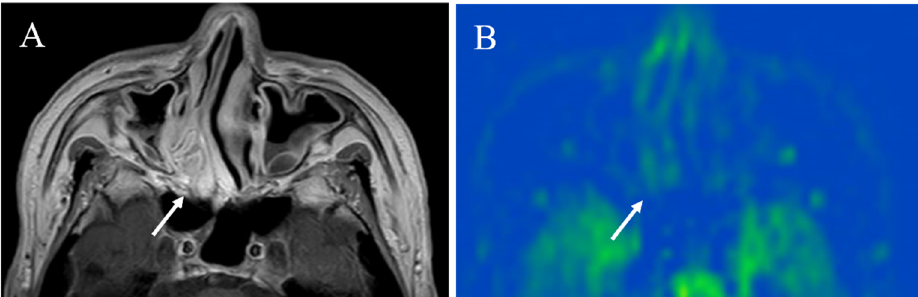
Figure 13. A 73-year-old male with inverted papilloma: ( A ) Contrast-enhanced T1-weighted image shows an enhanced mass with convoluted cerebriform pattern (arrow); ( B ) pCASL image shows a slight increase in blood flow within the lesion (arrow) (TBF mean of 39.46 mL/100 g/min). Ahn et al. evaluated the histogram TBF parameters derived from pCASL be- tween human papillomavirus (HPV)-positive and -negative in oropharyngeal SCC [79]. ation (SD) and 95th percentile of TBF, i.e., 27.8 vs. 37.7 mL/100 g/min for SD and 111.7 vs. 147.3 mL/100 g/min for 95th percentile of TBF [79].